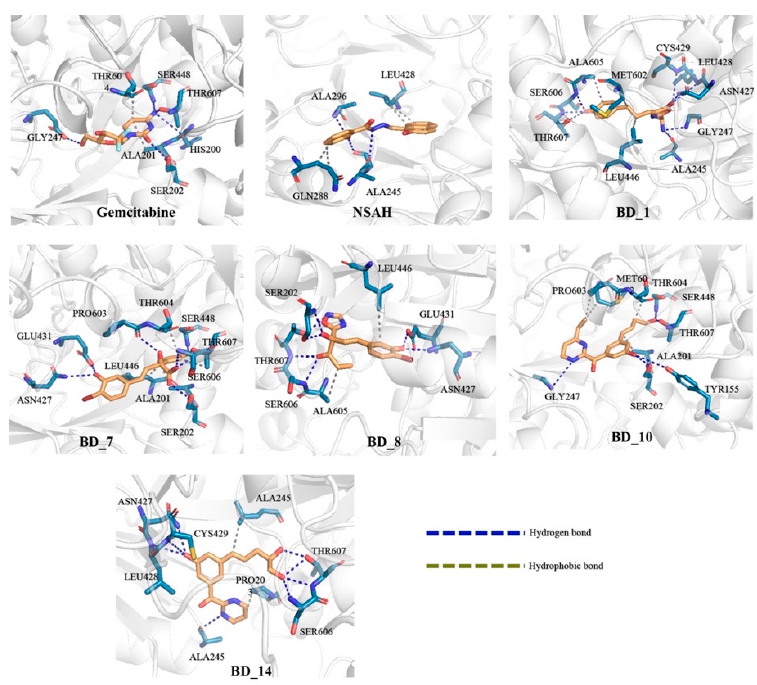
Figure 4. Binding interaction profile of top five molecules, gemcitabine, and NSAH.